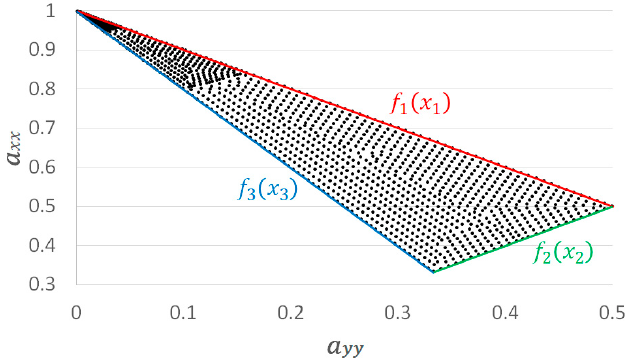
Figure 2. Delaunay ‐ based triangle mesh with the corresponding eigenvalue combinations. Figure 2. Delaunay-based triangle mesh with the corresponding eigenvalue